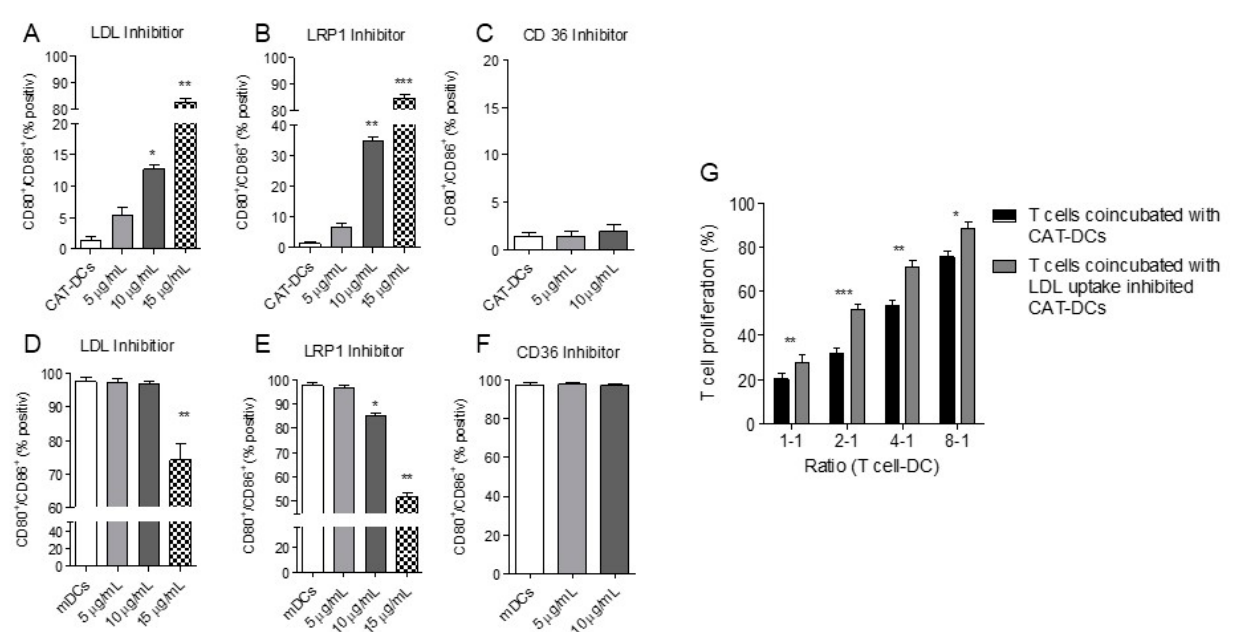
Figure 6. Inhibition of LDL-R and LRP1 restores expression of costimulatory molecules CD80 and CD86 in CAT-DCs and reduces their suppressive capacity . ( A – C ) Flow-cytometric detection of CD80/CD86 expression on CAT-DCs after inhibition of different LDL-uptake receptors in increasing doses through-out DC induction and maturation: inhibition of LRP1 ( A ), LDL-R ( B ), and CD36 (C; n = 5). ( D – F ) Flow-cytometric detection of CD80/CD86 expression on mDCs after inhibition of different LDL-uptake receptors in increasing doses through-out DC induction and maturation, inhibition: of LRP1 ( D ), LDL-R ( E ), and CD36 (F; n = 5). ( G ) Analysis of the effect of LDL-uptake-inhibited CAT-DCs on CD3/CD28-bead-activated allogenic T-cells: CAT-DCs +/ − LDL-inhibition as described above were cocultured with T-cells in decreasing T-cell:CAT- DC ratios ( n = 5). T-cell proliferation was quantified by flow-cytometry as described in Figure 2. Statistical analysis was performed with a paired two-tail Student’s t -test ( A – F ) and two-way ANOVA ( G ) * p < 0.05, ** p < 0.01, *** p < 0.001.